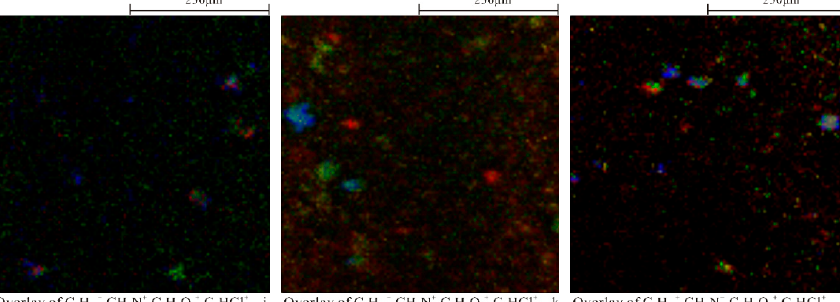
Figure 3. Ion-imaging superimposed images of four MPs ( a ) XA1; ( b ) XA2; ( c ) XA3; ( d ) XA4; ( e ) XA5; ( f ) XA6; ( g ) XA7; ( h ) XA8; ( i ) XA9; ( j ) XA10; ( k ) XA11; ( l ) XA12; 500 μ m × 500 μ m, 128 × 128 pixel.